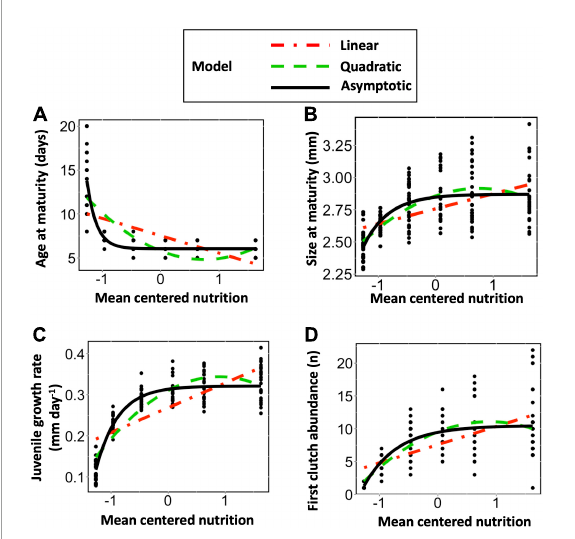
FIGURE1 Population-level reaction norms for (A) Age at maturity, (B) Size at maturity, (C) Juvenile growth rate and (D) First clutch abundance modeled using either a linear, quadratic, or three parameter asymptotic exponential function. Mean-centered nutritional gradient, spanning from 10,000 to 300,000 cells mL − 1 was fitted as a fixed